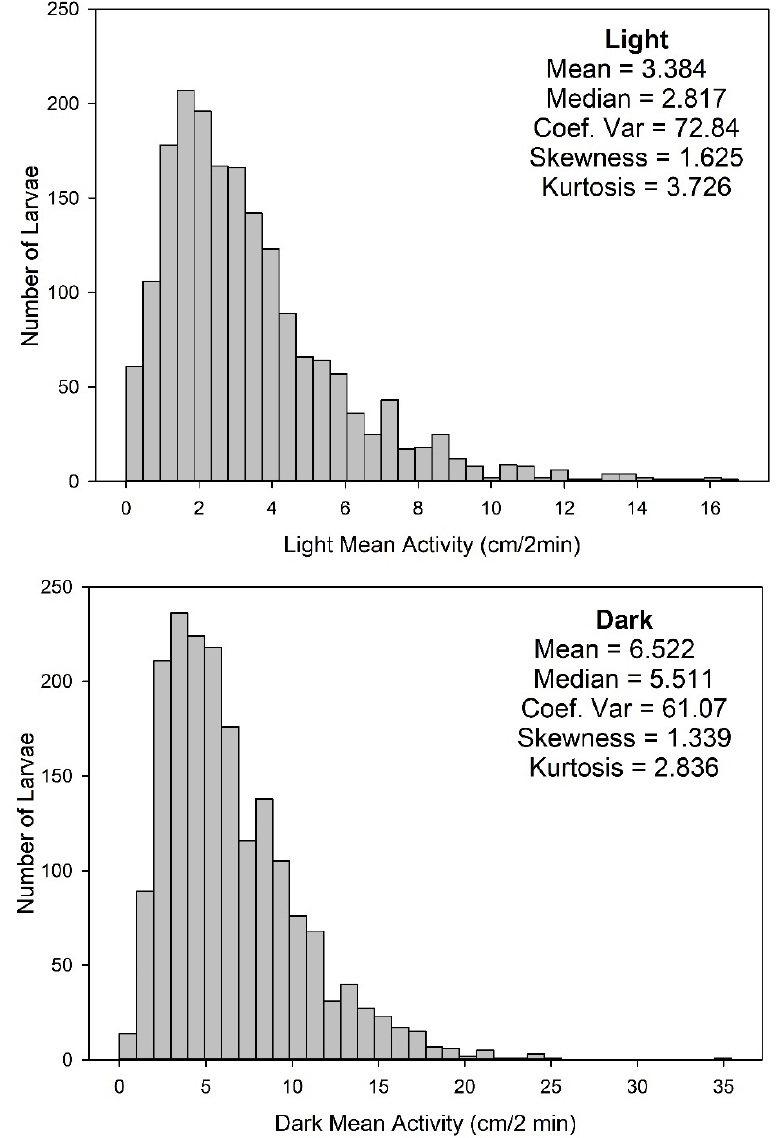
Figure 4. Histograms of the Distribution of the Control Activity for the Light and Dark Periods of Testing. The sum of the activity of the control animals (n = 1851) was plotted as a histogram to visualize the non-normal distribution of the data. Note that the activity intervals are different for the Light and Dark periods. Plots and data calculations were performed using SigmaPlot.